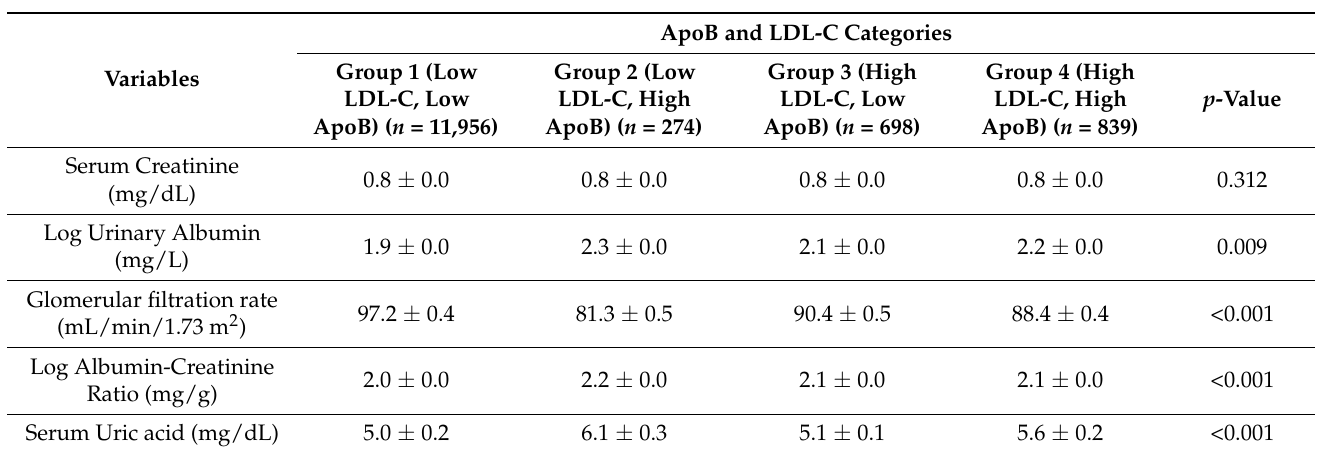
Table 2. Age, sex, race, fasting blood glucose, systolic and diastolic blood pressure, body mass index, diabetes and hypertension-adjusted mean of markers of kidney function based on LDL-C and ApoB concordant/discordant